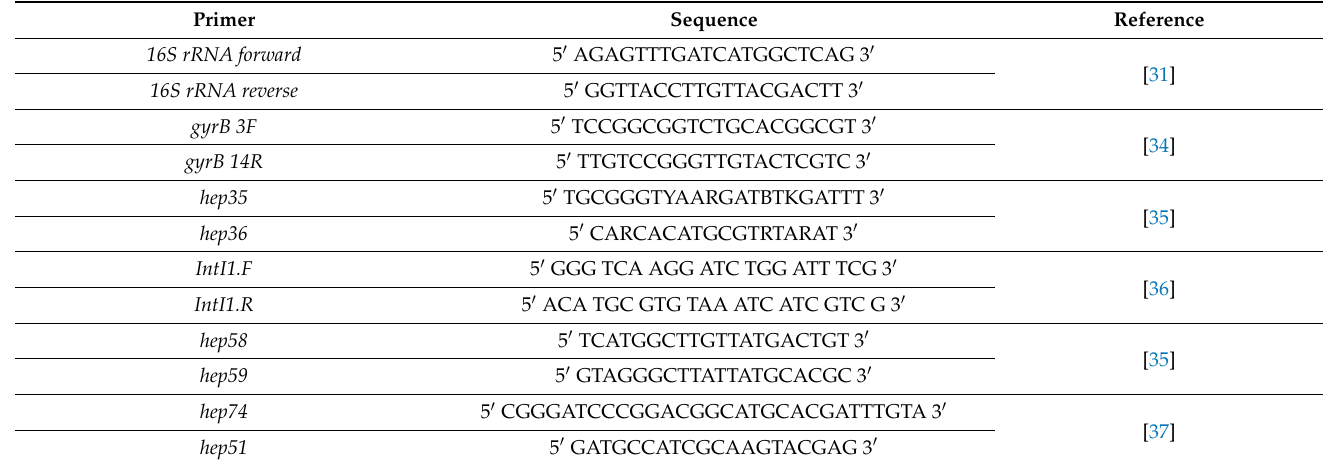
Table 1. Sequences of oligonucleotide primers used in this